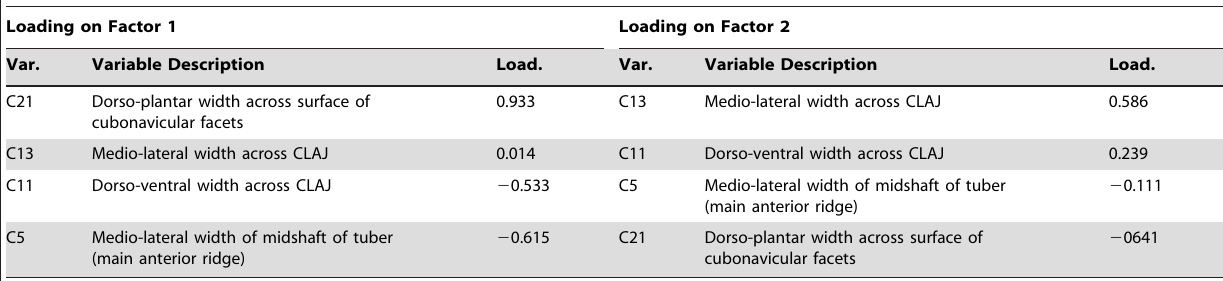
Table 5. Coefficient loadings Discriminant Analysis: Calcaneum